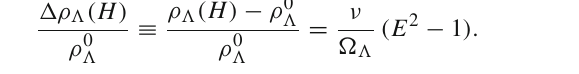
Fig. 5 Left panel Evolution of G ( z )/ G 0 based on Eq. (7) at leading order in ν G . We use ν G = 0 . 001 from the fit of the RVM to the overall cosmological data [59–61]. Right panel As in the left panel , but now